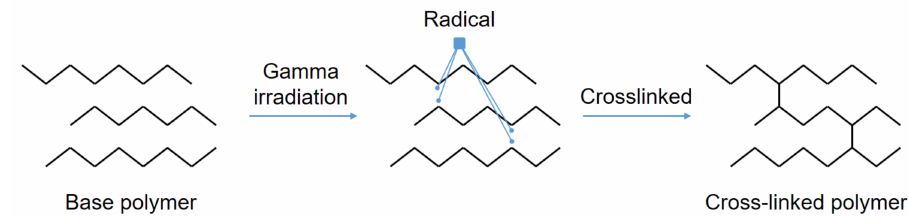
Figure 4. Schematic diagram of crosslinking reaction according to gamma irradiation.